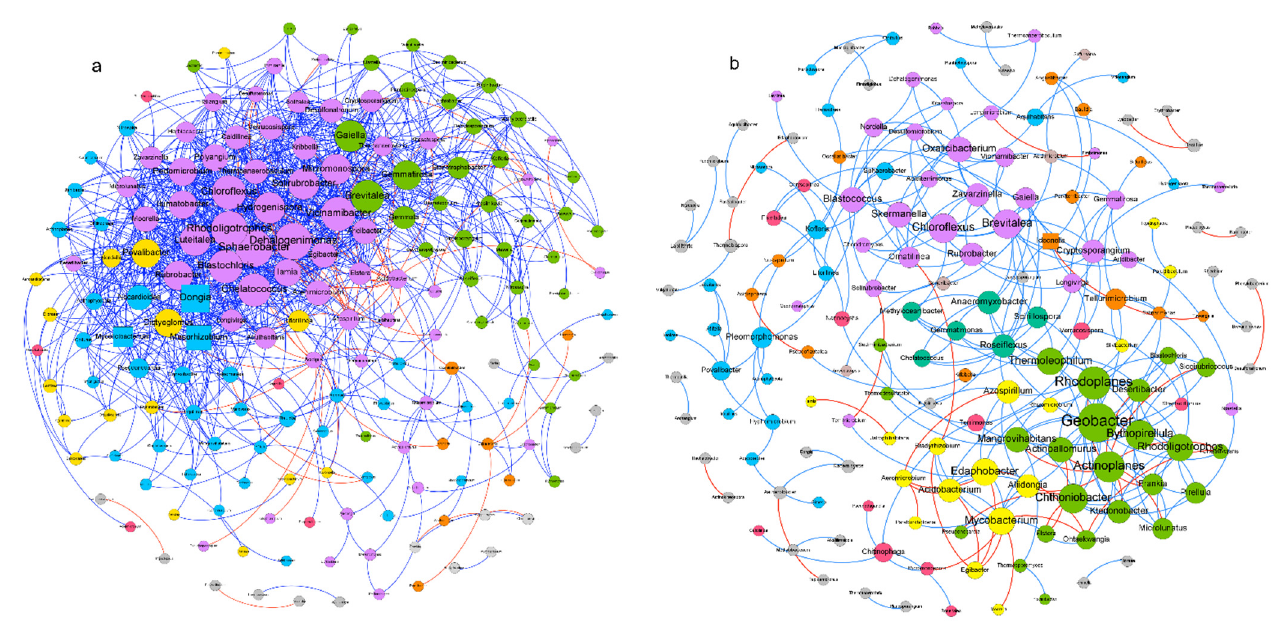
Figure 3. Empirical networks of bacterial communities in the low fire frequency ( a ) and high fire frequency ( b ) sites. The network nodes (bacterial genera) are colored according to modules (assemblage), while their sizes are proportional to their node degree. Peripheral nodes and connectors are round-shaped, while module hubs are square-shaped. The network edges represent significant direct interactions among phylotypes. The edges colored in red represent negative interactions, while those in blue are positive interactions.